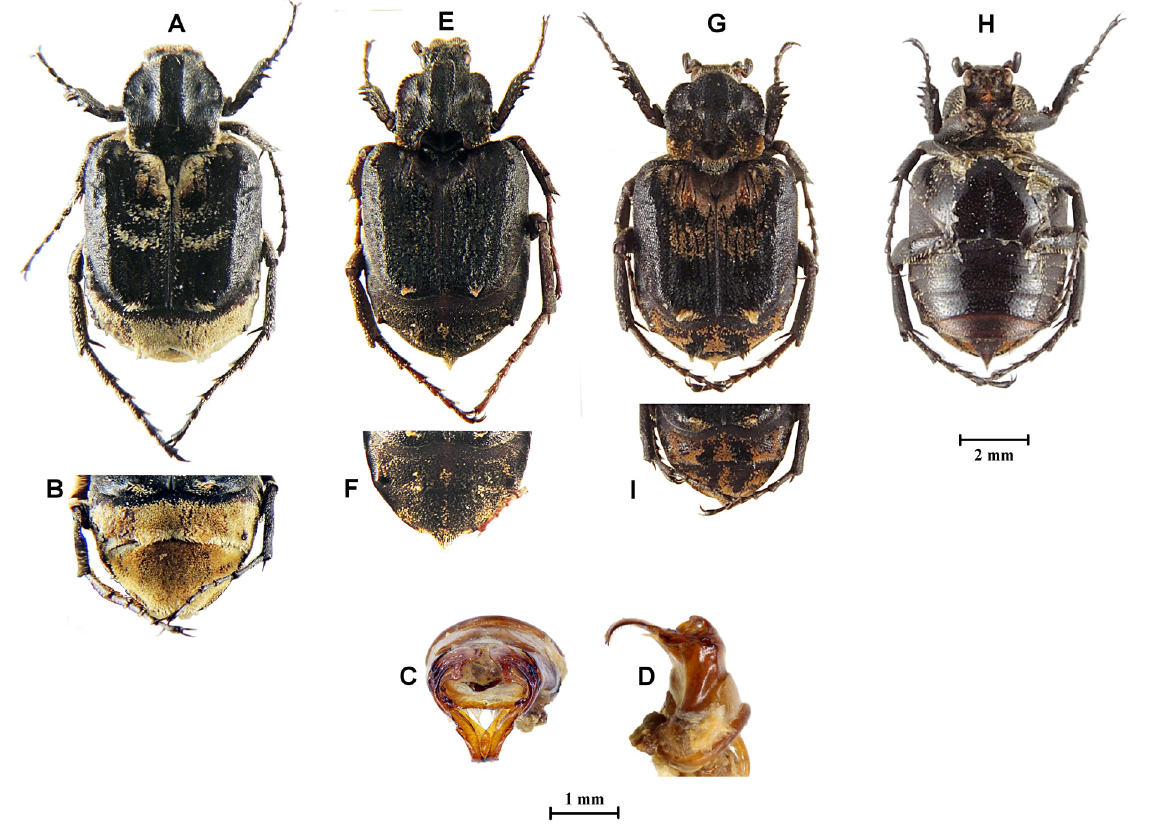
Fig. 11. A–D . Hybovalgus tonkinensis Moser, 1904. A–B . ♂ from Fujian (ERC). A . Habitus, dorsal view. B . Propygidium and pygidium. C–D . PLT, ♂ (MNHUB). C . Aedeagus, dorsal view. D . Aedeagus, lateral view. E–I . Excisivalgus klapperichi Endrödi, 1952. E–F . HT, ♀ (ZFMK). E . Habitus, dorsal view. F . Propygidium and pygidium. G–I . PT, ♀ (ZFMK). G . Habitus, dorsal view. H . Habitus, ventral view. I . Propygidium and